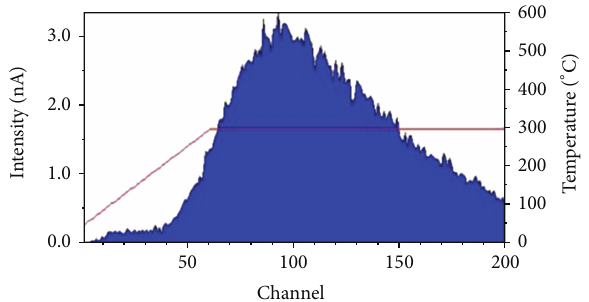
Figure 4: The glow curve for the undoped potassium borate glass following 6MV photon irradiations. Table 1: Identification of the compositions and concentrations of undoped potassium borate glass by SEM. Element